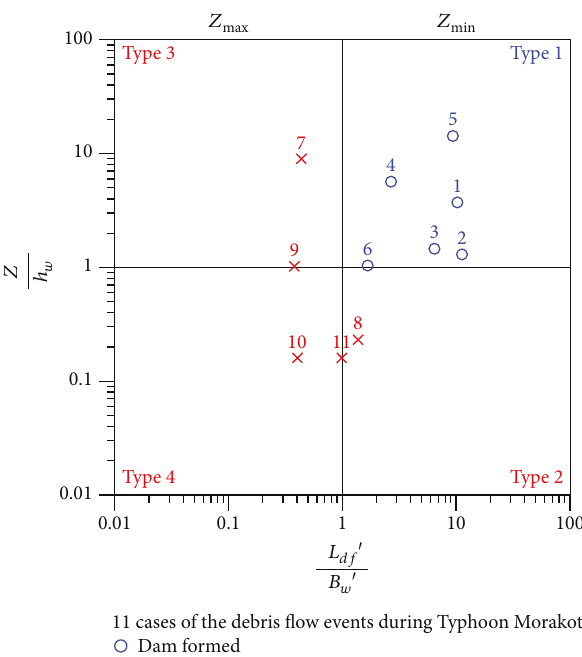
Figure 5: Assessment results of the tributary debris fl ow entering the main stream for 11 tributary debris fl ow events during Typhoon